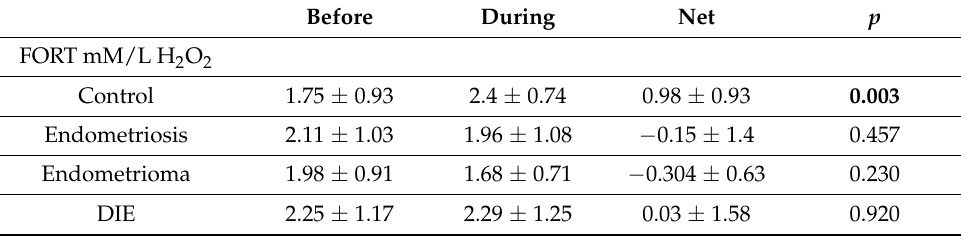
Figure 1. FORT/FORD values before and during hormonal contraception. * Significant vs. pretreat- ment values. & Significant vs. controls (please, see text for details). Table 4. Mean and standard deviation (mean ± SD) of blood oxidant (FORT), antioxidant (FORD), and the oxidant/antioxidant ratio (FORT/FORD) observed prior to and after 3 months of estradiol- based hormonal contraception in women without (controls; n = 24) and with endometriosis ( n = 52), of which 26 had endometrioma alone, and 26 had deep infiltrating endometriosis, associated or not with ovarian